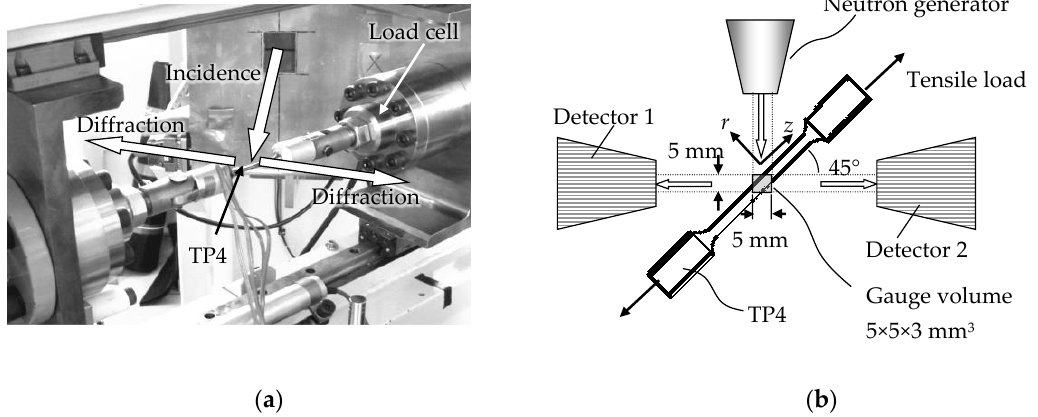
Figure 5. Setup image and optical system of neutron diffraction measurement of hollow cylinder specimen. ( a ) Measurement in radial ( r ) and axial ( z ) directions, ( b ) Measurement in radial ( r ) and hoop ( h ) directions [13].